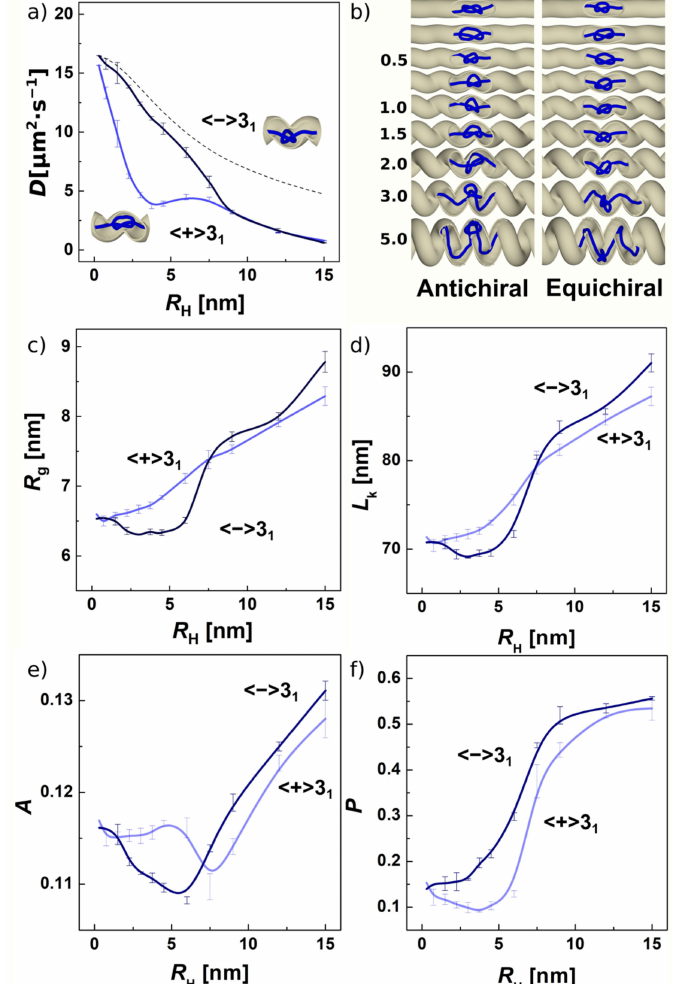
Figure 3. Effect of radius of the helix R H on dynamic and geometrical properties. ( a ) Speed of self-reptation of righthanded < − >3 1 and lefthanded knots <+>3 1 placed in negatively wound helical channel ( ω -) representing equichiral and antichiral system; dashed line corresponds to effective diffusivity predicted for a given tortuosity D eff = D 0 / τ = D 0 L / C . ( b ) Snapshot of trefoils in helical channels for different radii of helix indicated by numbers. ( c – f ) Dependence of geometrical de- scriptors gyration radius, R g , knot length, L k , asphericity, A , and prolateness, P , with the radius of the